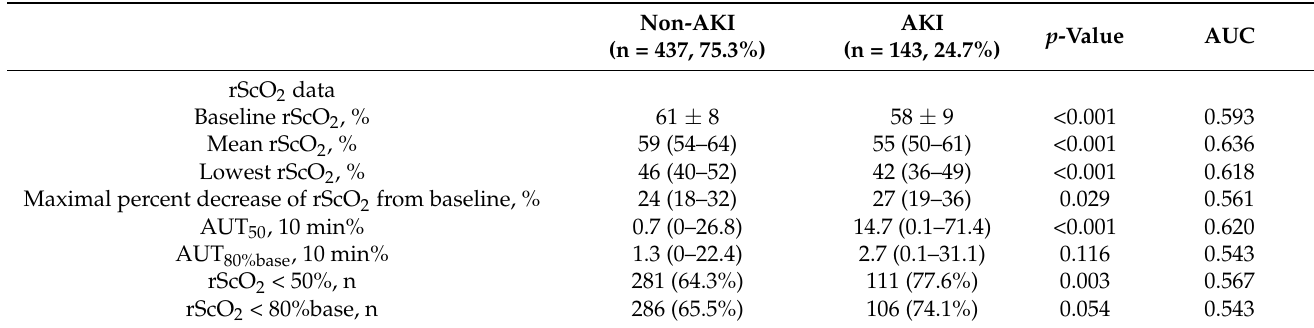
Table 2. Intraoperative cerebral oximetry parameters.